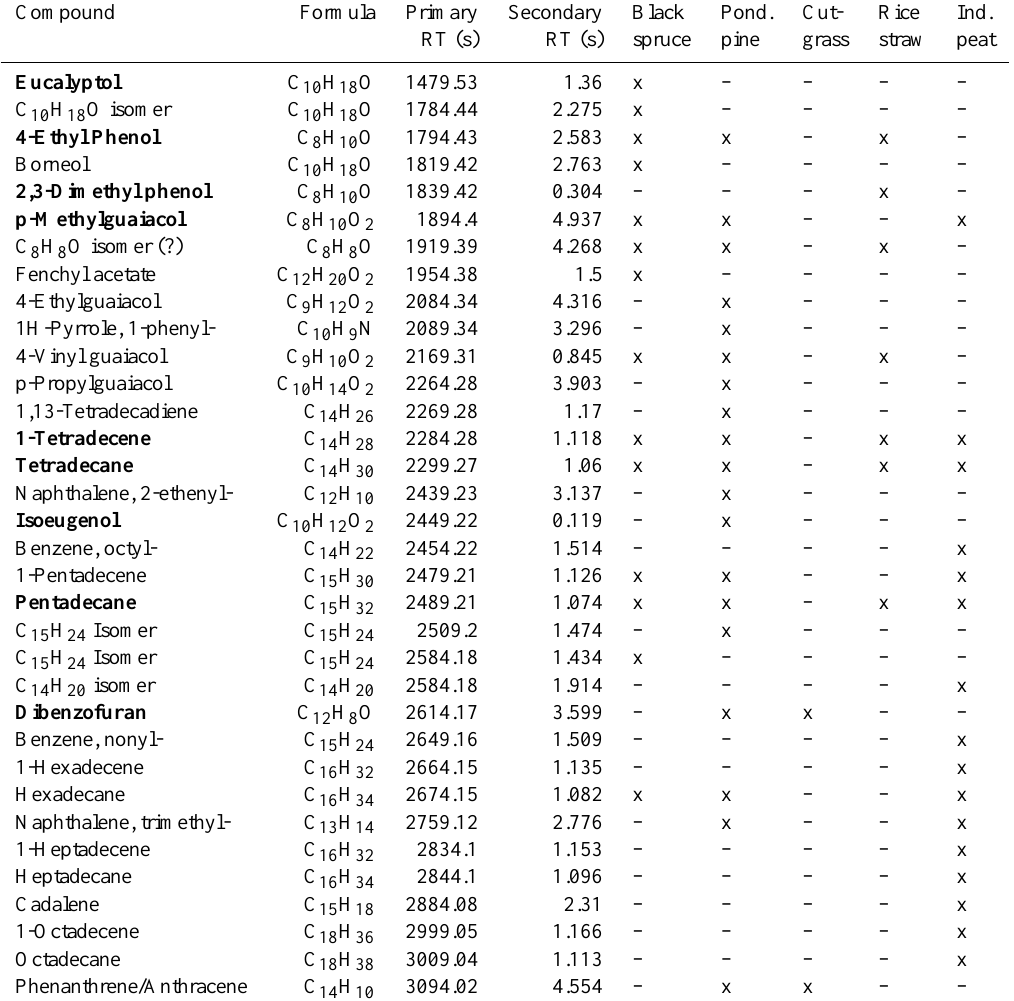
Table 2. Volatilizable compounds observed in the filter-desorption samples. Compounds in bold were positively identified by comparison with commercial standards. No unique compounds were observed in the wiregrass sample (see Sect. 2.1.3).